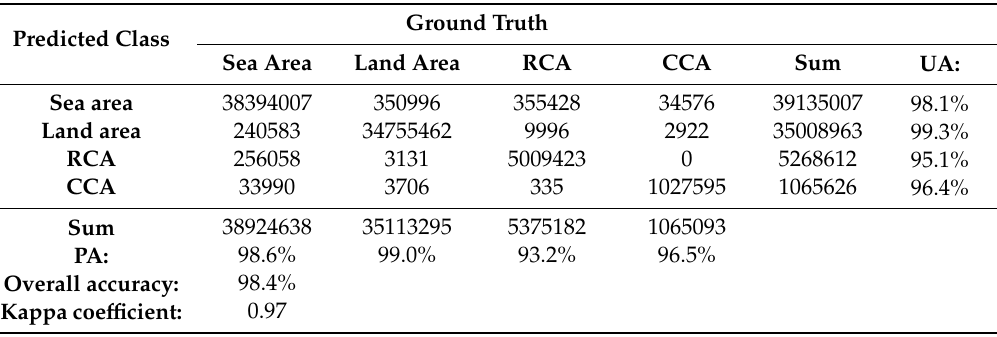
Table 2. Confusion matrix for the final classification results.